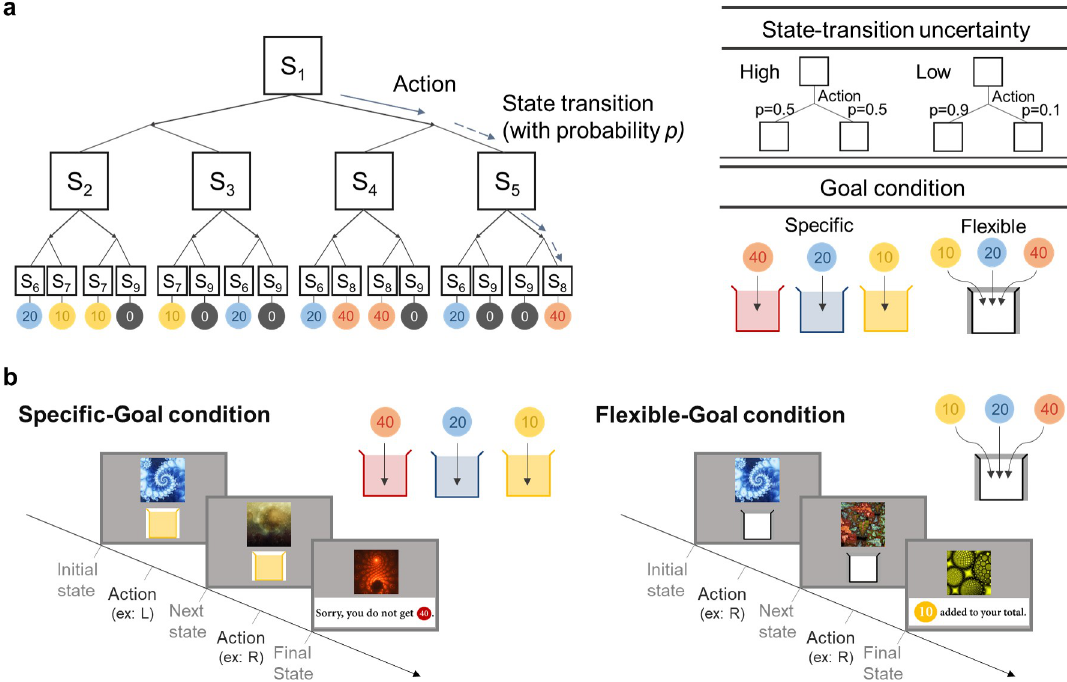
Fig 1. Markov decision task structure. We use the two-stage Markov decision task proposed by Lee et al. (2014). (a) Two-stage Markov decision task. In each stage, participants make a binary choice (left or right). After the first choice in the initial state (S 1 ), they were moved forward to one of four states in the second stage (S 2 or S 3 when making the ‘left’ choice, S 4 or S 5 when making the ‘right’ choice) with certain state-action-state transition probability p . The transition probability (0.5, 0.5) and (0.9, 0.1) corresponds to a high- uncertainty and a low-uncertainty environment, respectively. The task consists of the two goal conditions: a specific-goal and a flexible-goal condition. In the specific goal condition, subjects can collect coins (redeemable for monetary reward) only if the coin color matches with the color of the token box (red, blue, yellow). In the flexible goal condition indicated by the white token box, all types of coins are redeemable. (b) Illustration of the task. Each state is associated with a specific fractal image. When the initial state is shown on the screen, participants make a binary choice, and by doing so they proceed to the next state; the state transition follows the state-transition probability. In the next state, the participants make a binary choice to get to an outcome state. Each outcome state is associated with a specific coin (red, blue, yellow). In the specific-goal condition, participants collect the coin only when the color of the coin matches with the color of the given box, whereas in the flexible-goal condition, they collect coins regardless of its color.